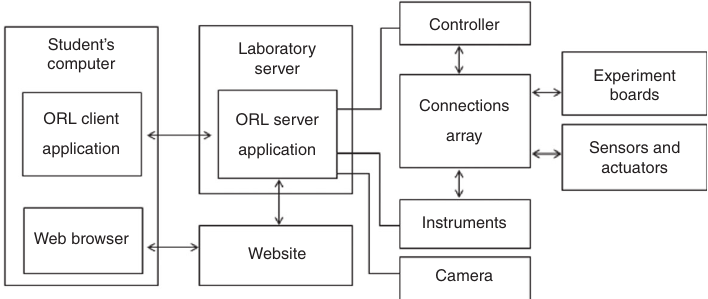
Figure 6. The ORL system